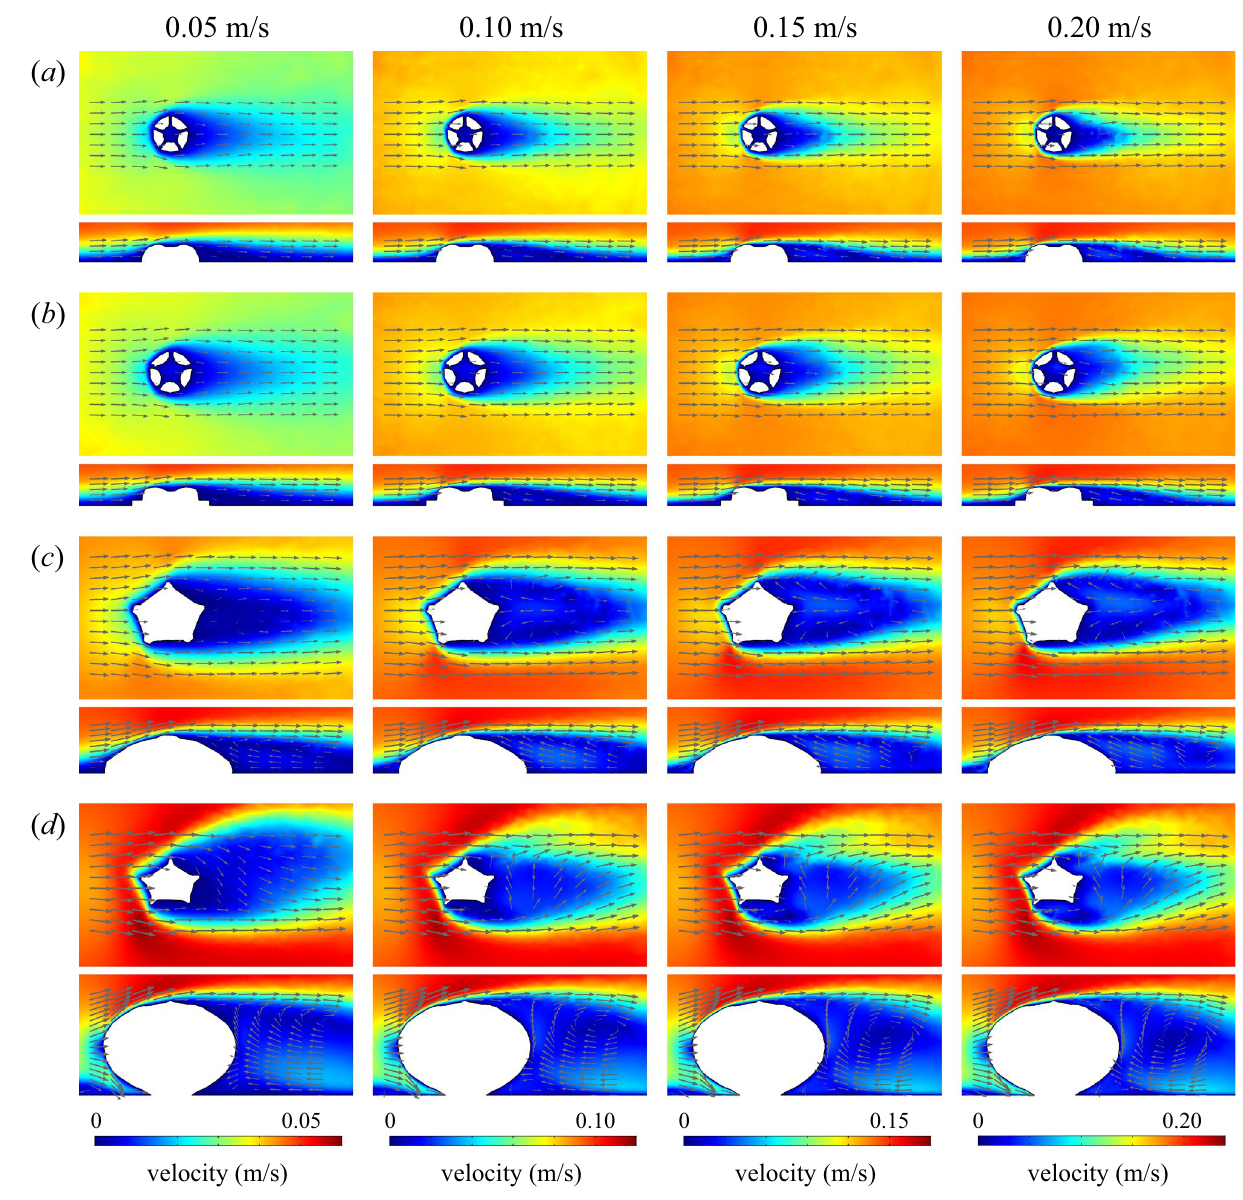
Figure 2. Two-dimensional surface plots (horizontal and vertical cross-sections) of velocity magnitude with flow vectors (size of arrows proportional to natural logarithm of flow velocity magnitude) at four different inlet velocities (0.05–0.20 m/s). ( a ) Arkarua morphotype 1. ( b ) Arkarua morphotype 2. ( c ) Cambraster . ( d ) Stromatocystites . Direction of ambient flow from left to